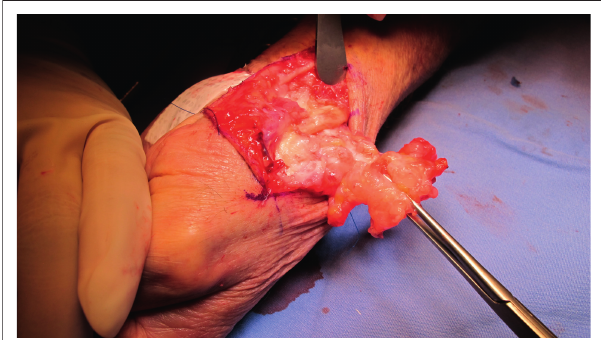
FIGURE 7: At surgery, a complex, infiltrating, locally aggressive cystic mass was confirmed.